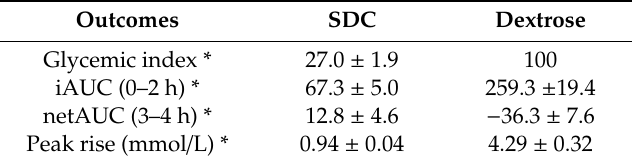
Table 3. Post-prandial glycemic response of SDC and dextrose.